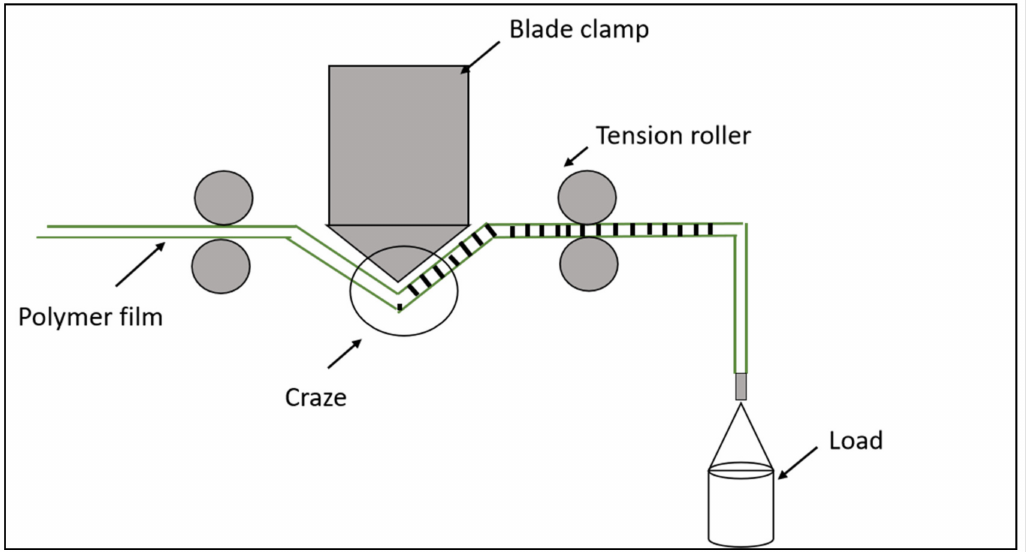
Figure 1. Instrument set-up used for the crazing process for the PLA/PAni